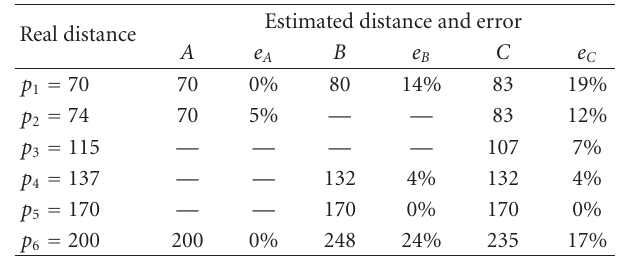
Table 7: Validation results (using the moving object detection